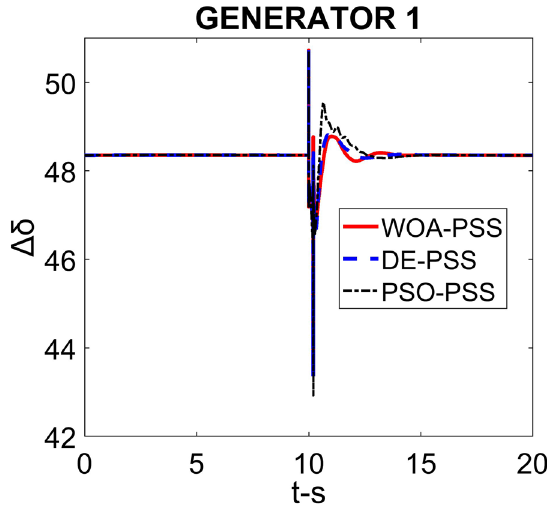
Fig. 15 speed deviation of G3 under 3- φ fault at t = 10 s Fig. 17 delta deviation of G1 under 3- φ fault at t = 10